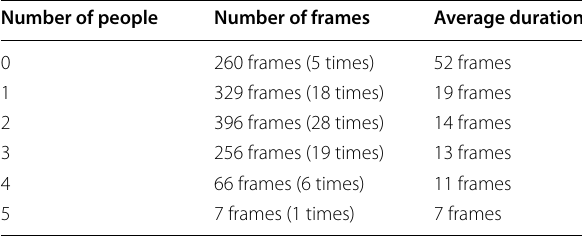
Table 4 The result of off-line experiments Method